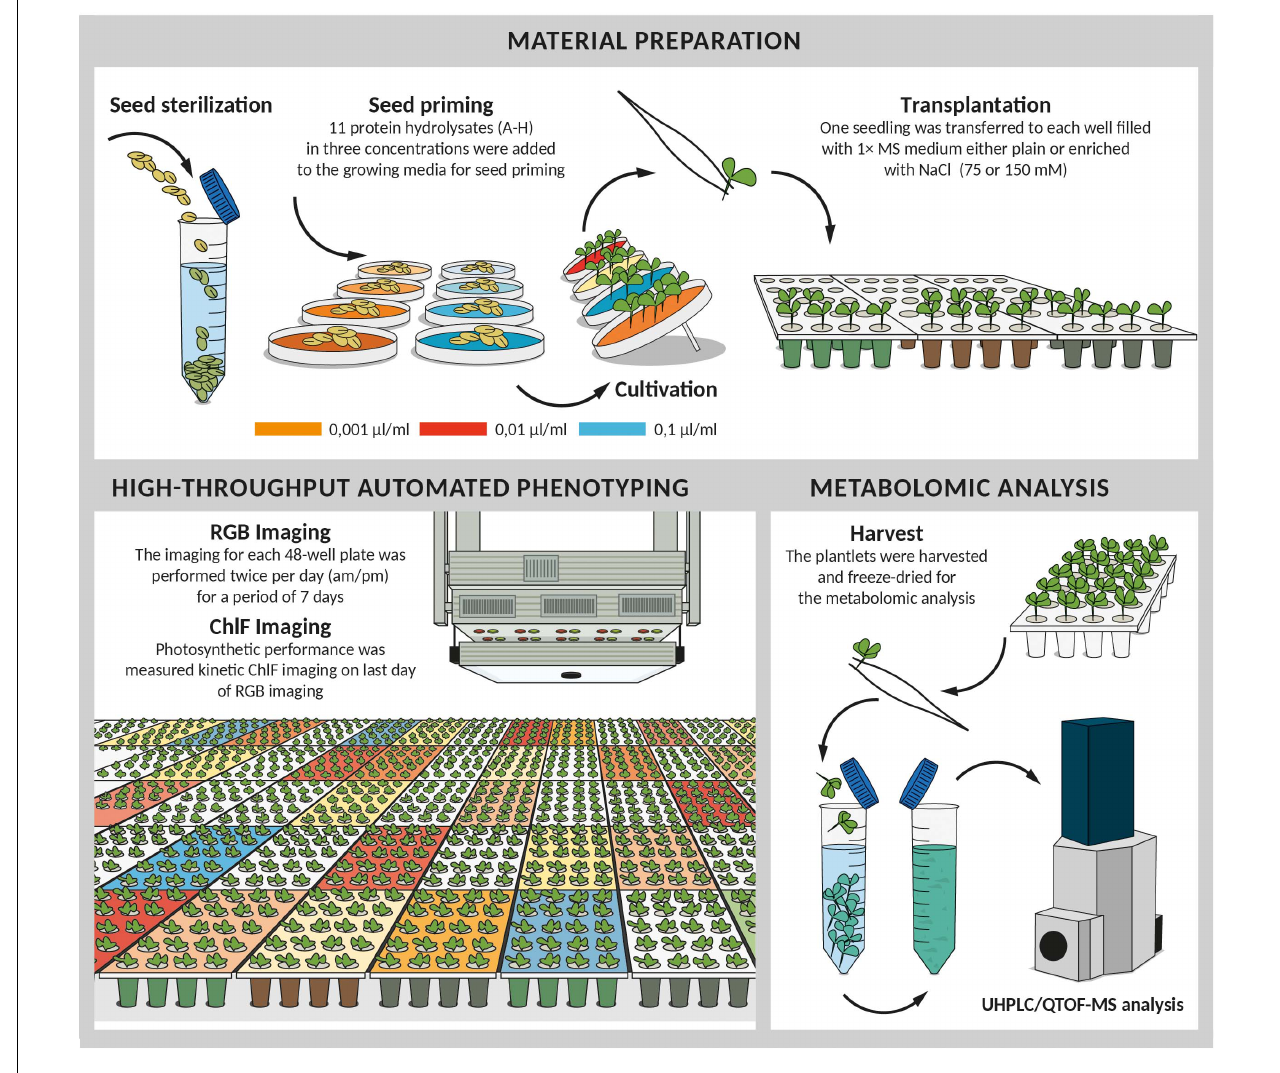
FIGURE 1 | Scheme of experimental protocol for high-throughput screening of biostimulant impact on Arabidopsis growth in control and salinity conditions. After sterilization seeds were germinated in 0.5 × MS mixed with 11 different protein hydrolysates at three concentrations (0.001, 0.01, and 0.1 µ l/ml). 4 days after cold stratification, seedlings of similar developmental stage were transplanted into 48-well plates with fresh MS medium either simple or supplemented with NaCl (75 mM or 150 mM). Plates were placed for 7 days to the cultivation chamber with XYZ PlantScreenTM System used for daily (am and pm) automatic RGB imaging and growth analysis. At the end of the phenotyping period, the plates were used for the measurement of the chlorophyll fluorescence. Following the last measurement, the plantlets treated with the best-performing biostimulants including the controls were harvested, freeze-dried and used for subsequent metabolomic